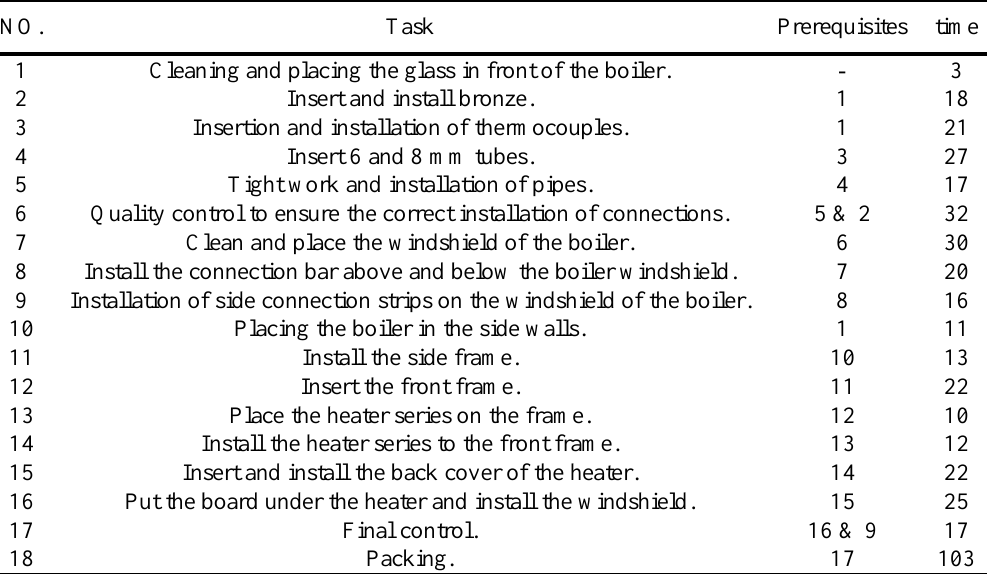
Table 3. Information on each element in the heater assembly